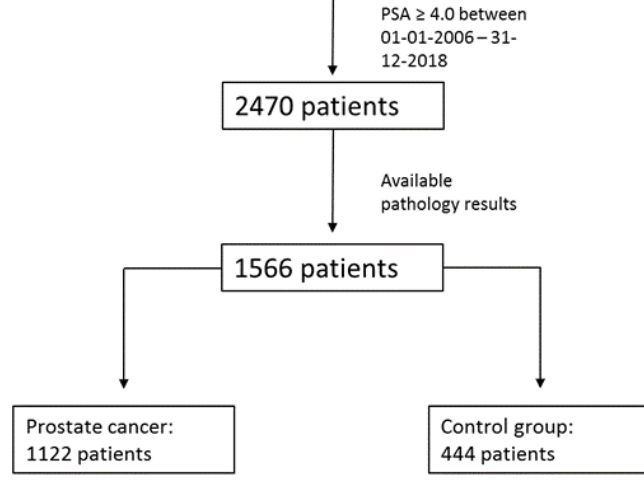
Figure 1. Flowchart including patients.